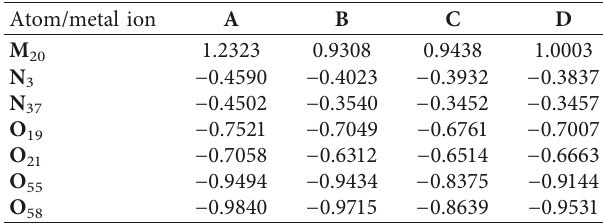
Table 4: NPA charges on the ligand donor atoms and the central metal ions in the complexes investigated, computed at BP86-D3